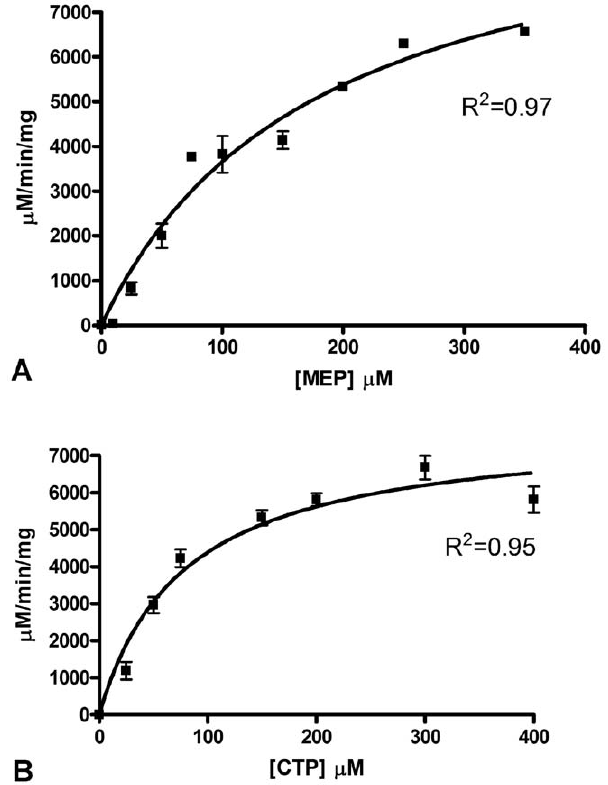
Figure 2. Purification of recombinant F.tularensis MEP cytidy- lyltransferase. A) Coomassie stained SDS-PAGE showing a molecular weight marker (MW) and purified His-tagged MEP cytidylyltransferase. His-tagged MEP cytidylyltransferase has a predicted molecular weight of 29.5 kDa. B) Western blot hybridization analysis of purified MEP synthase using an anti-His antibody results in an intense band of the expected size.